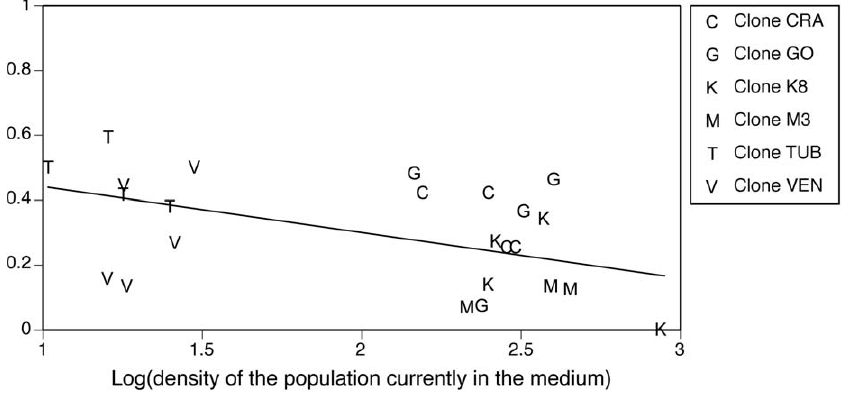
Figure 1. Relationship between population density and the proportion of dispersing cells in experiment 1. As in Fellous et al. (2011) we find a significant negative correlation between the natural concentration of paramecium cells and dispersal. Each point represents an independent replicate.